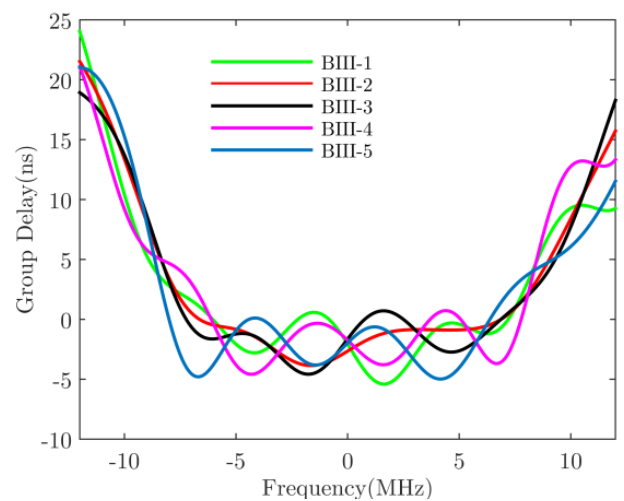
Figure 11. BIII-2 group delay